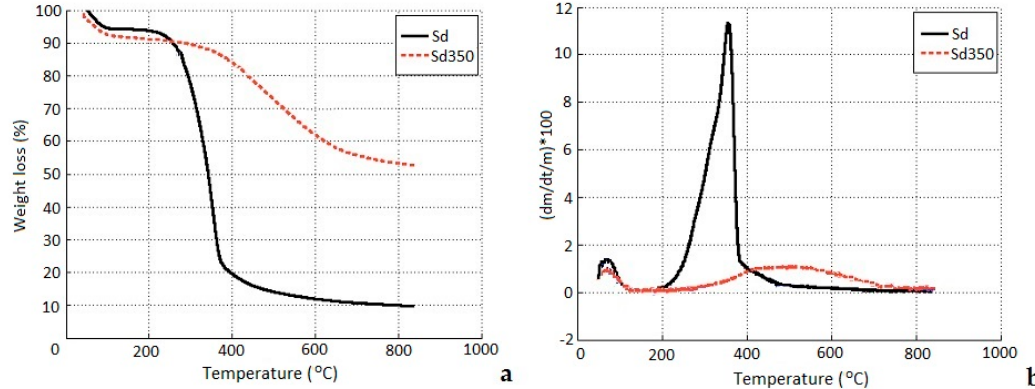
Figure 3. TG ( a ) and DTG curves ( b ) versus temperature evolution, for Sd and biochar Sd350.